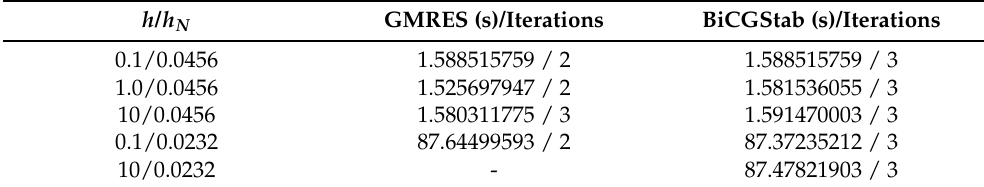
Table 3. CPU time for the solution of linear systems resulting from Orthogonal I type of grids using the ILU( k ) preconditioner, with k = 300,